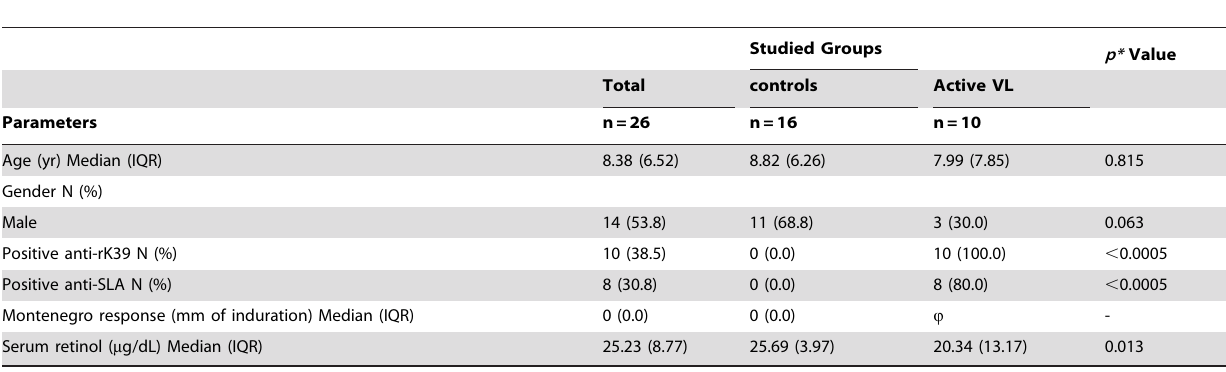
Table 1. Characteristics of the studied groups by age, gender, anti- Leishmania antibodies, Montenegro skin test response and serum retinol